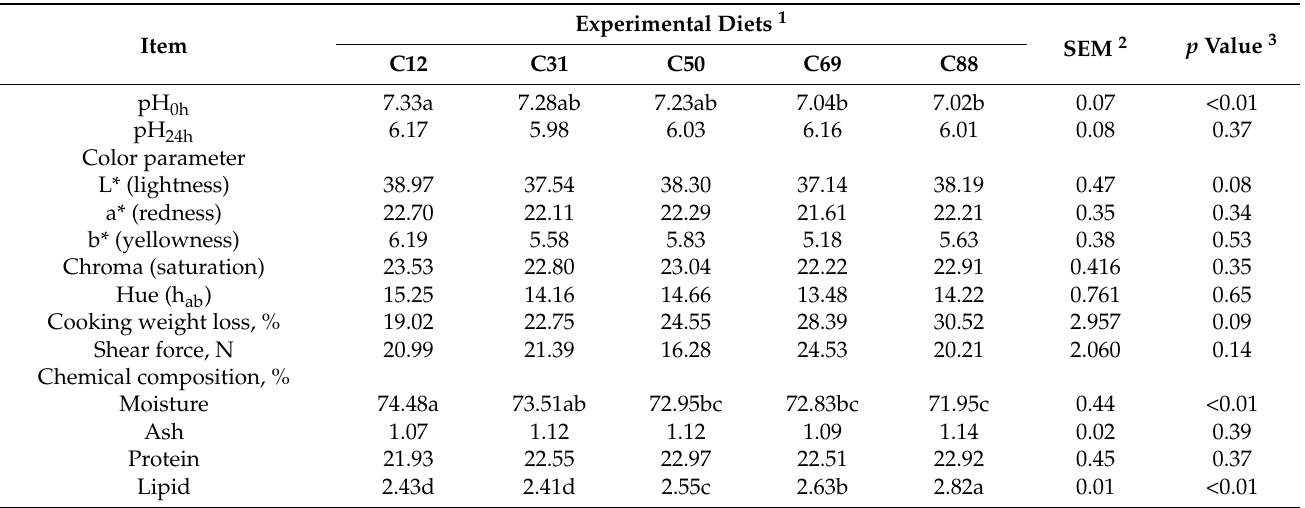
Table 6. Effect of dietary forage-to-concentrate ratios on physicochemical composition of the Longis- simus lumborum muscle from